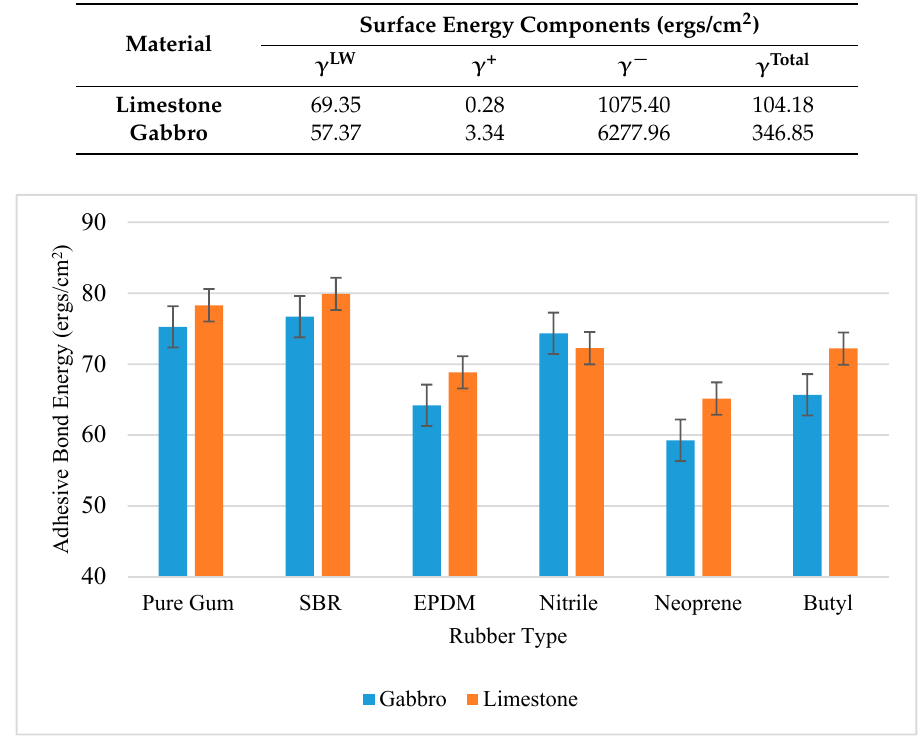
Table 6. Measured surface energy of aggregates using universal sorption device (USD) device, (adapted from [20]).